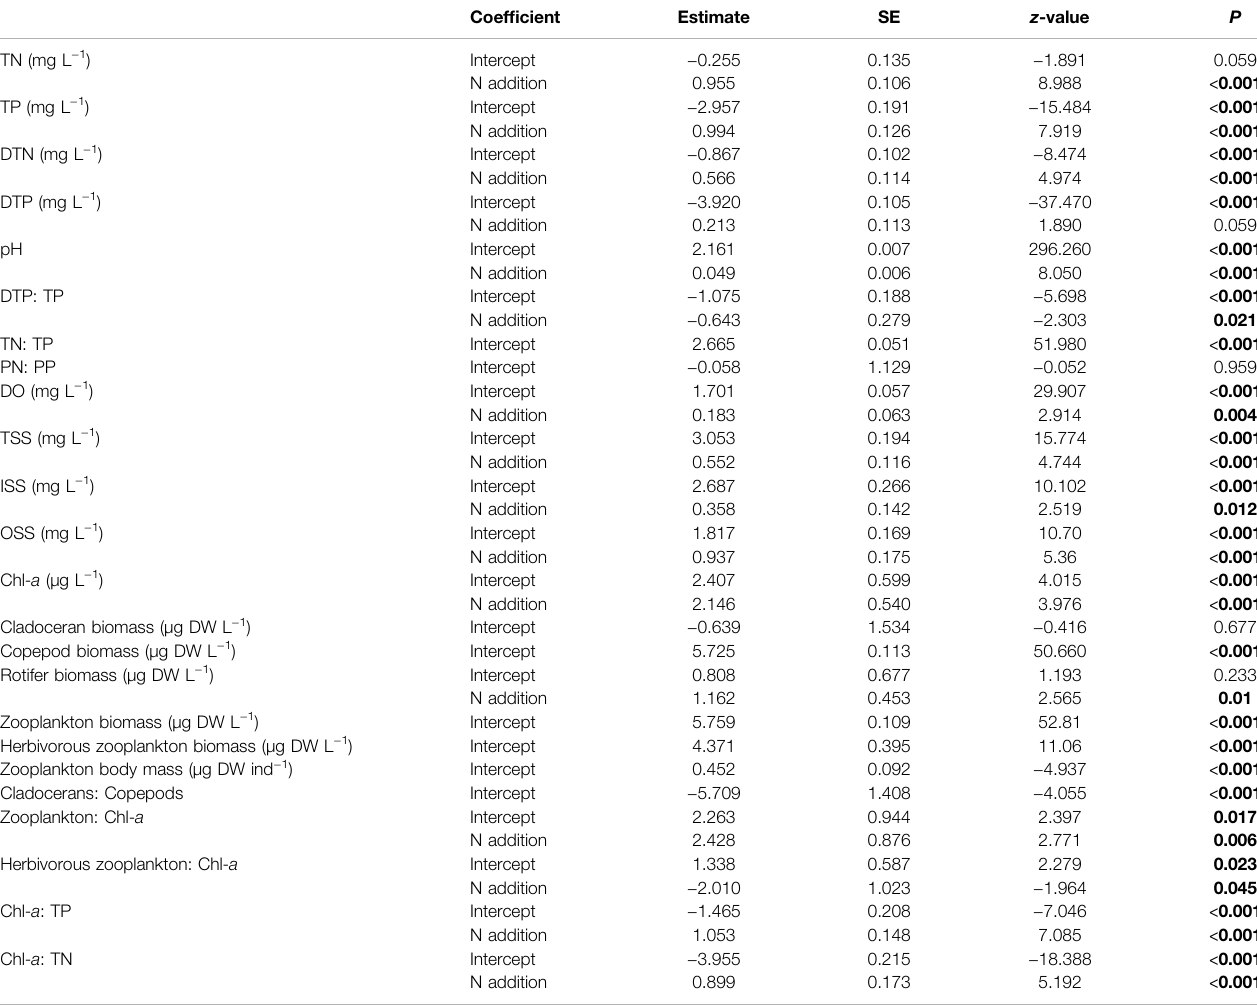
TABLE 1 | Best results of the generalized linear mixed model using the function glmmTMB from the R package glmmTMB v1.0.2.1 (Brooks et al., 2017). Coef fi cient